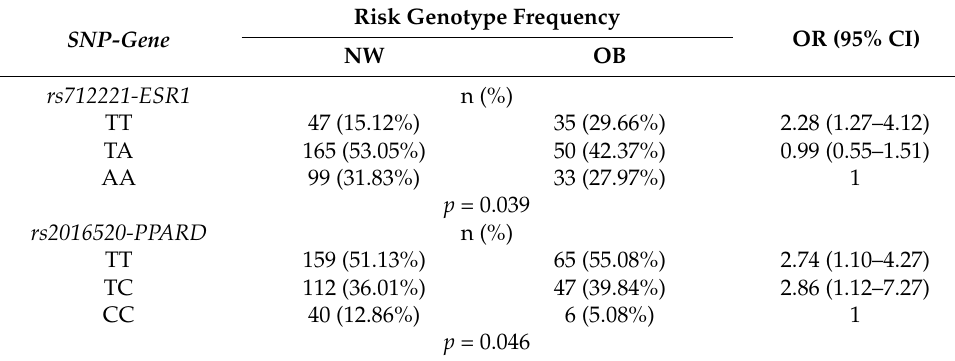
Table A2. The genotypes distribution on rs712221 (ESR1) and rs2016520